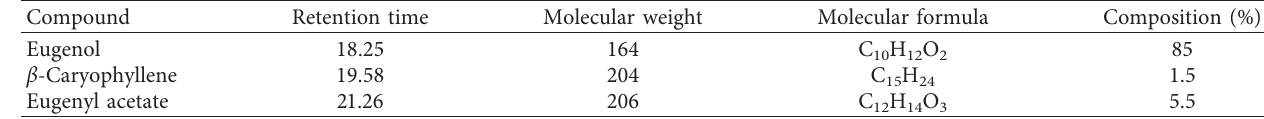
Table 1: Main compounds determined in clove ( Eugenia caryophyllata ) essential oil.